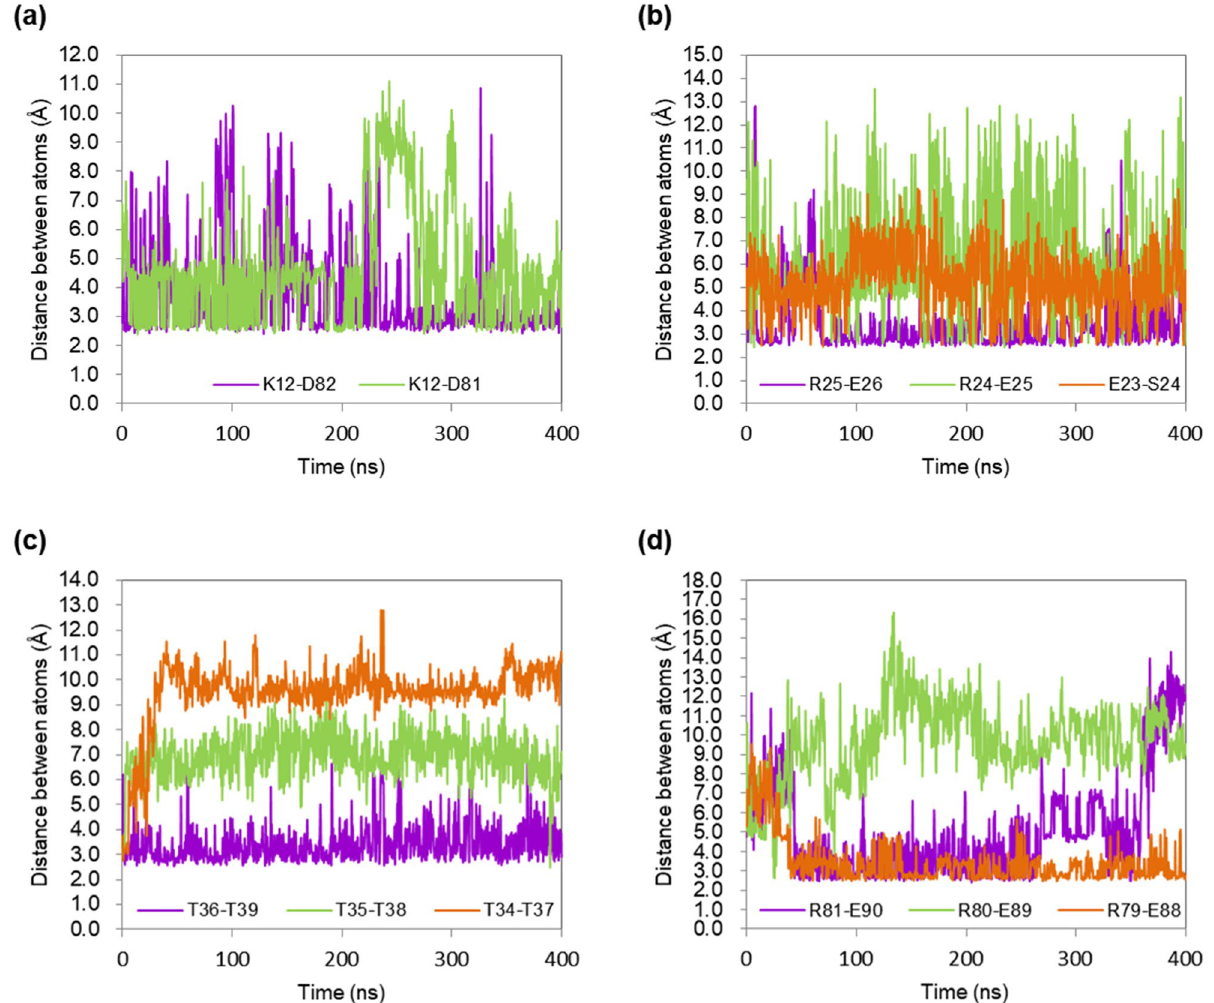
Figure 7. Interaction distance between residues that can affect RMSF in MGSs. Purple, green and orange correspond to the interactions between residues at homologous positions in opMGS, tsMGS, and cdMGS, respectively, with the residue number insets. ( a ) Salt bridges between specific lysines and aspartates in opMGS and tsMGS. The lysine is replaced by a methionine and cannot form a salt bridge in cdMGS; ( b ) Salt bridges between specific arginines and glutamates in opMGS and tsMGS. The salt bridge is replaced by a hydrogen bond between glutamate and serine in cdMGS; ( c ) Hydrogen bonds between specific threonines in the three MGSs; ( d ) Salt bridges between specific arginines and glutamates in the three